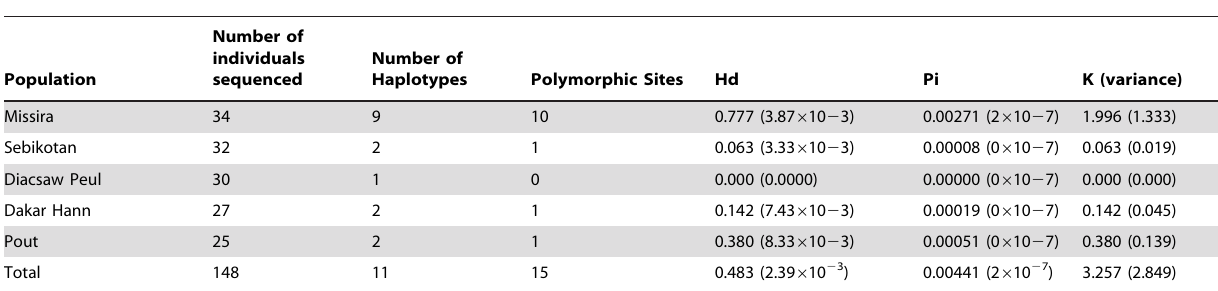
Table 2. Diversity statistics for the studied populations based on COI sequences.